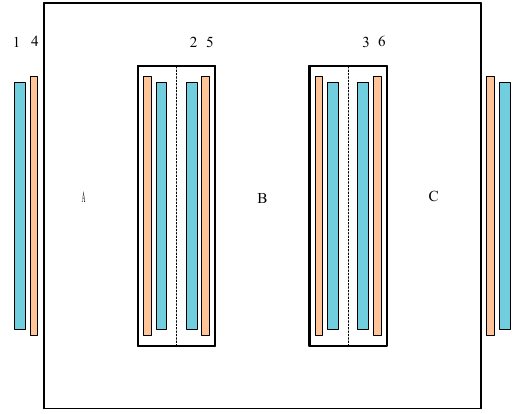
Figure 1. Locations of three phase transformer windings.